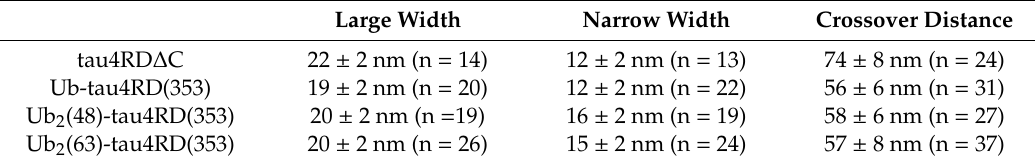
Table 2. Morphological properties of the twisted filaments of tau protein samples obtained from the analysis of TEM